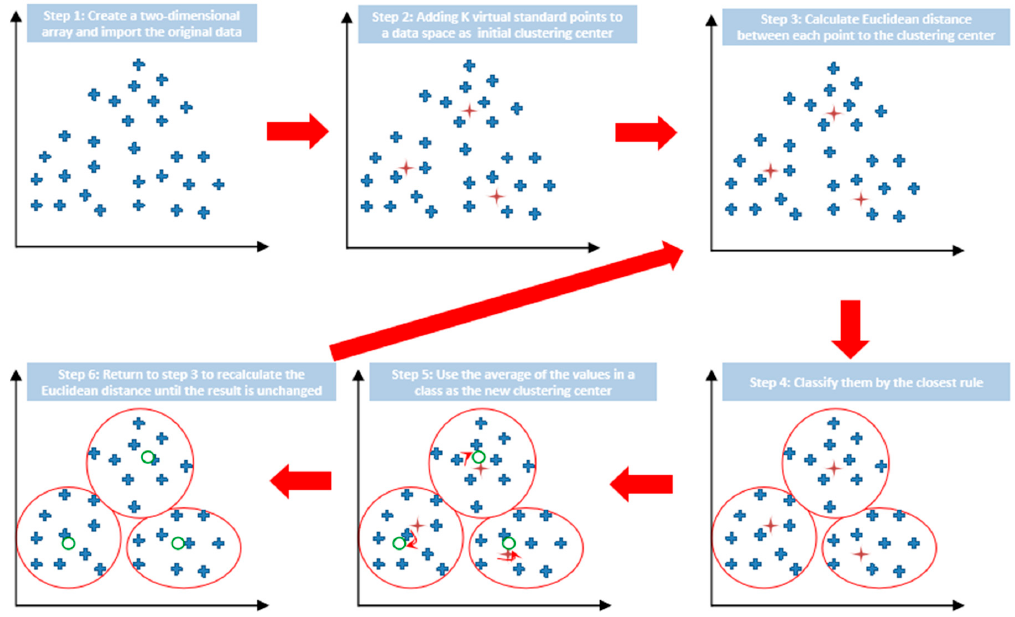
Figure 1. The calculation principle of the K-means clustering algorithm.2.2 eclectic vehicles (EVs) clustering strategy.